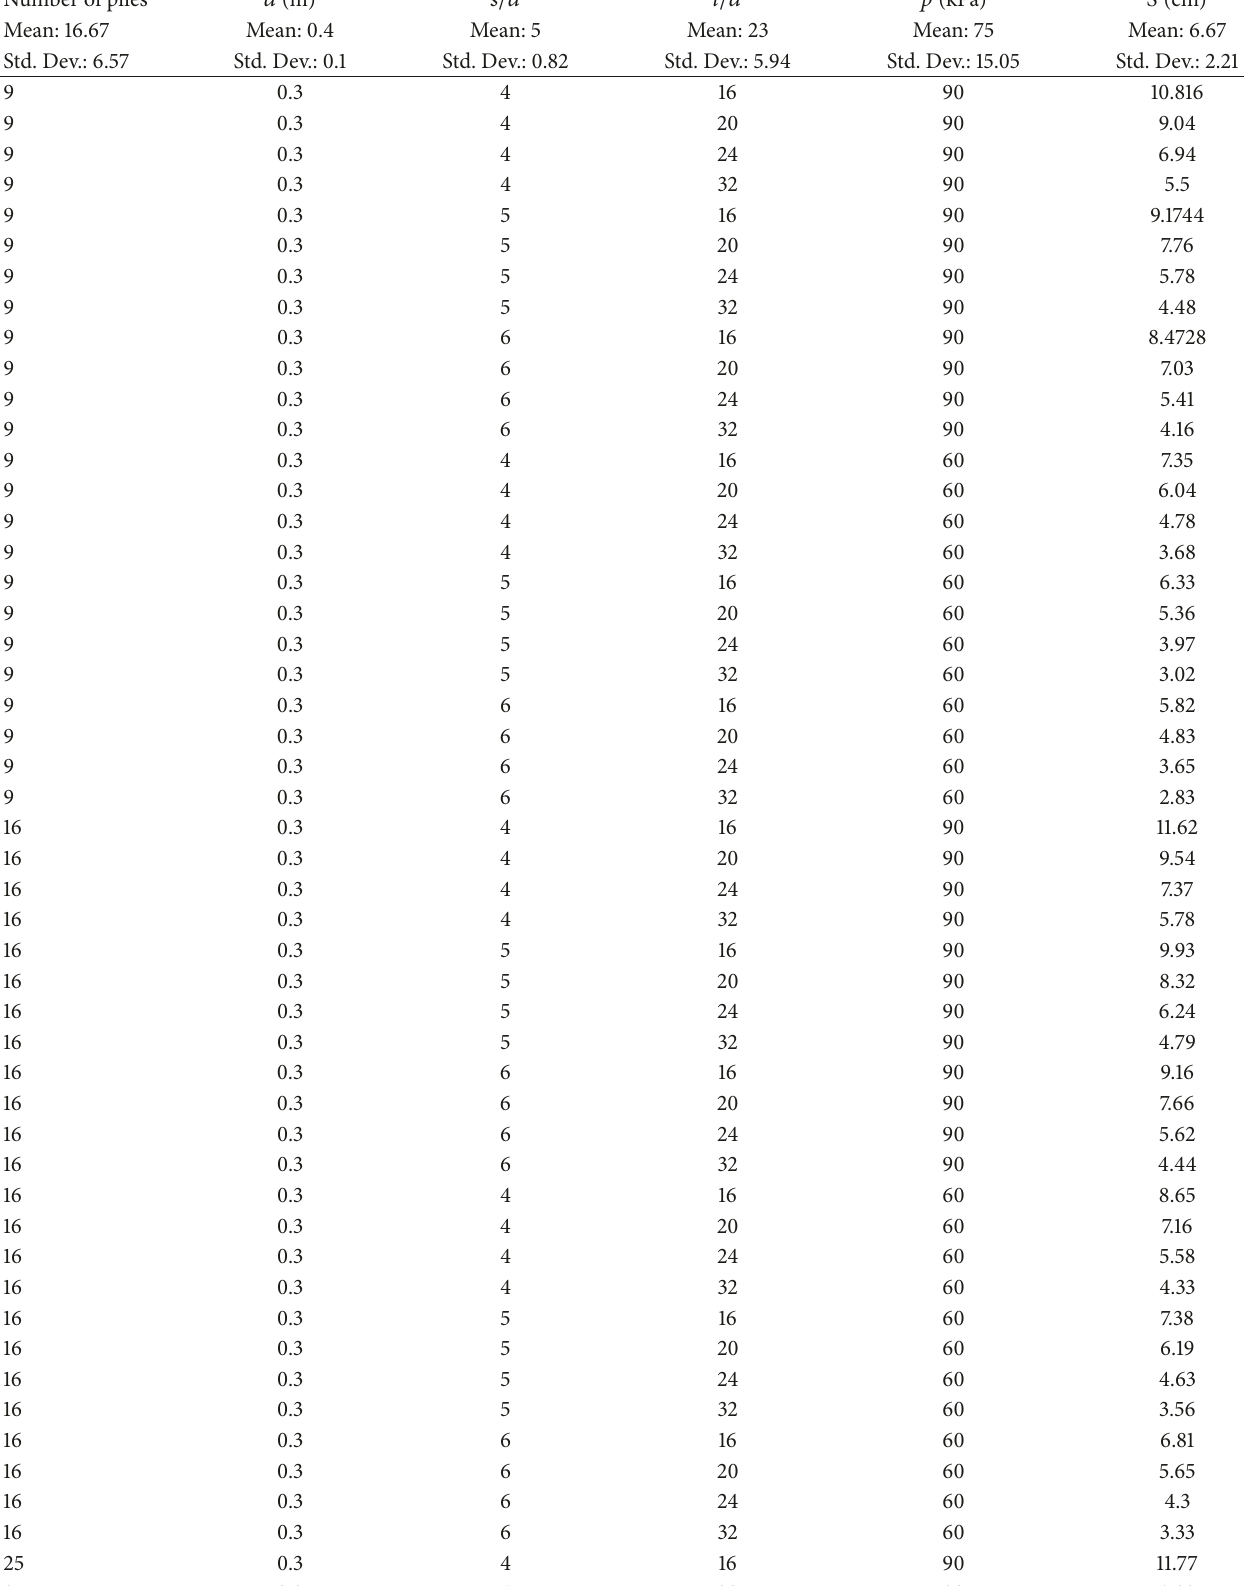
Table 2: Parametric study on the whole affecting parameters for combined static-dynamic loading